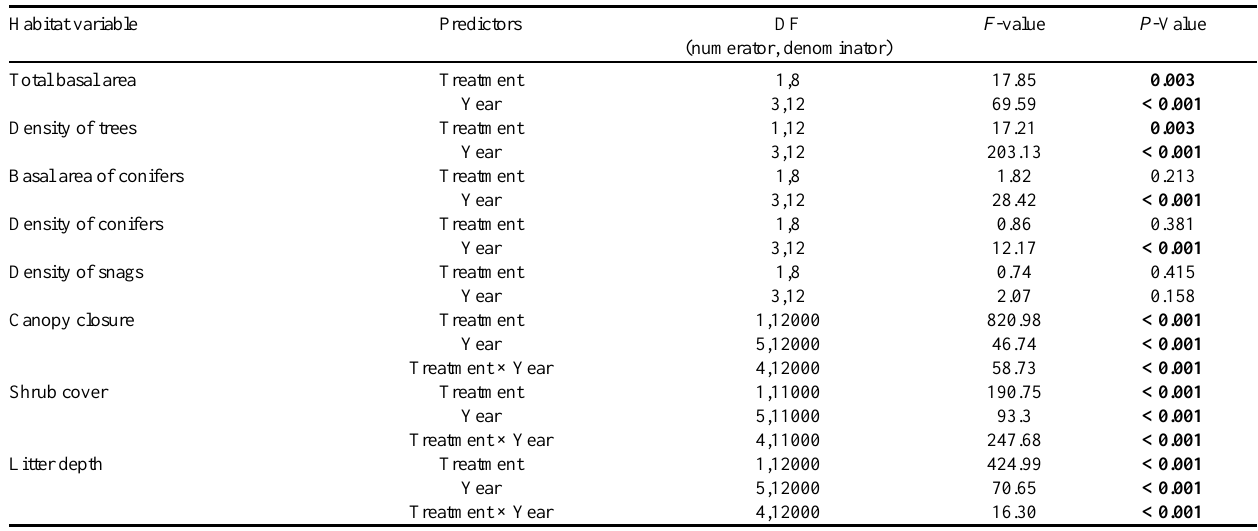
Table 2 . Linear mixed models relating habitat variables to treatment (selection harvesting), year, and their interaction. Values in bold indicate significant effects, i.e., P -values < 0.05.